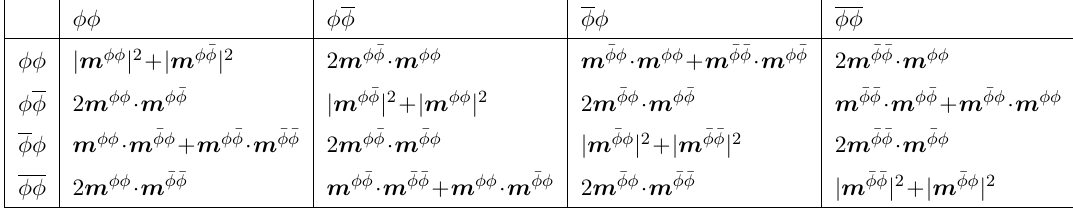
Table 1 . Sum rule for complex scalar